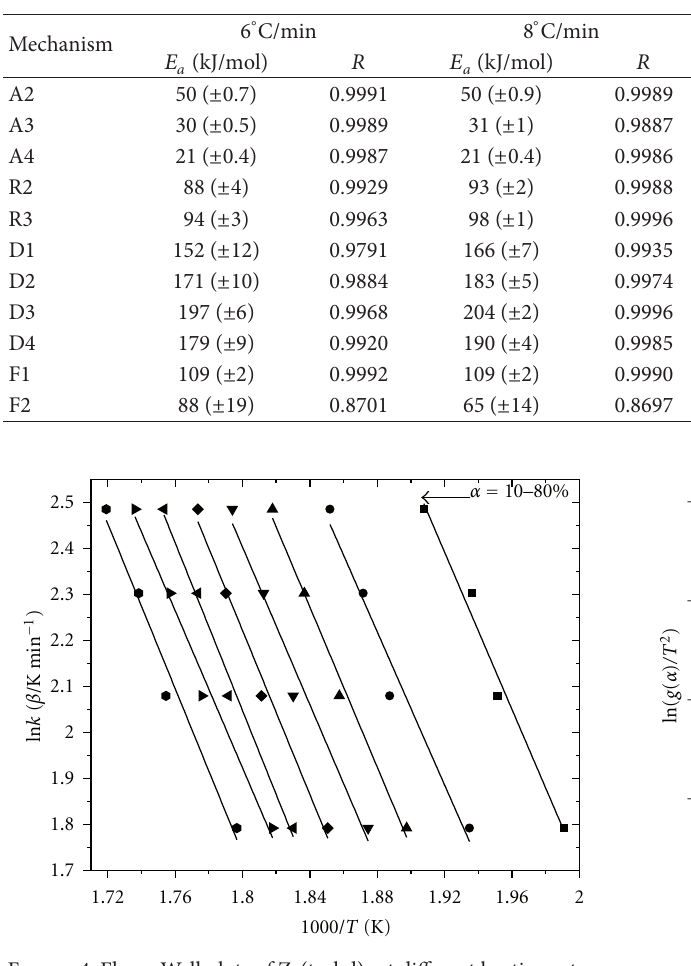
F 4: Flynn-Wall plots of Zr